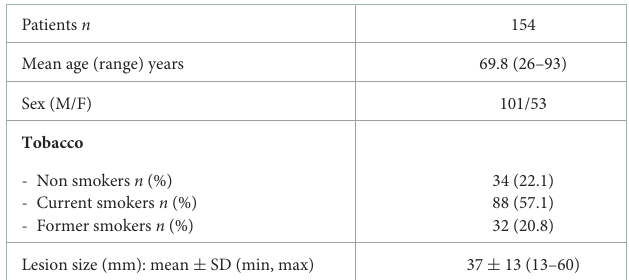
TABLE 1 Characteristics of the patients.